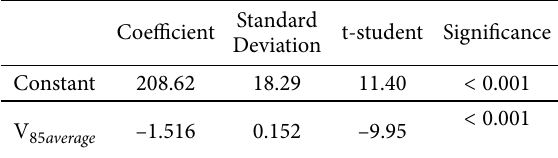
Table 7. ‘t-student’ test, model